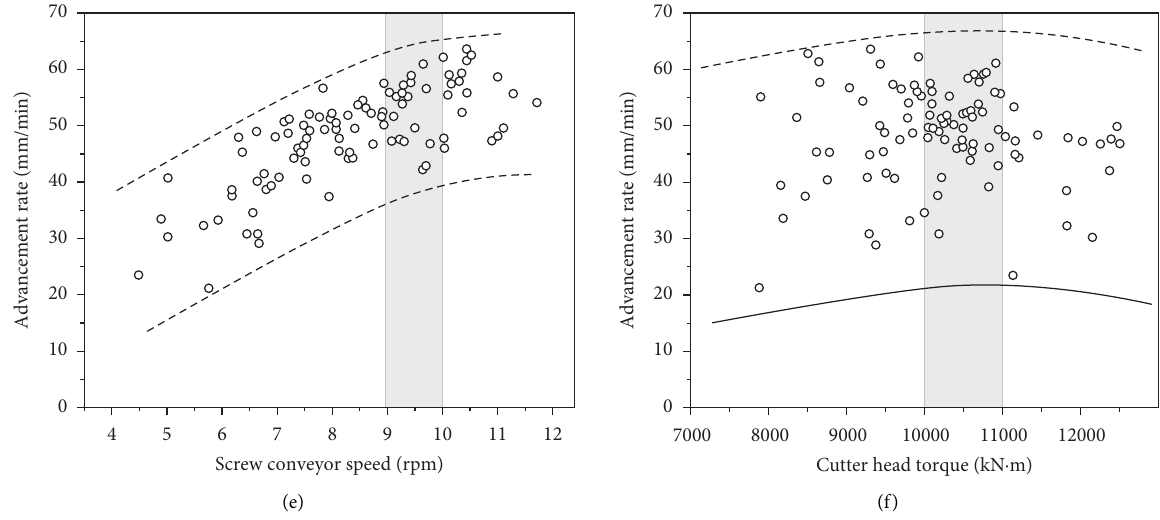
Figure 7: Relationships between operational parameters and advancement